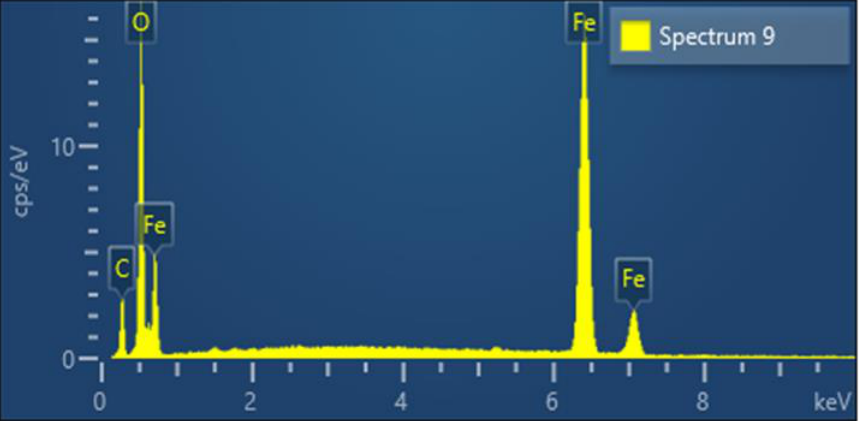
Figure 7. EDX analysis of certain particles after oxidation, containing mostly iron oxide (spectrum 9) .